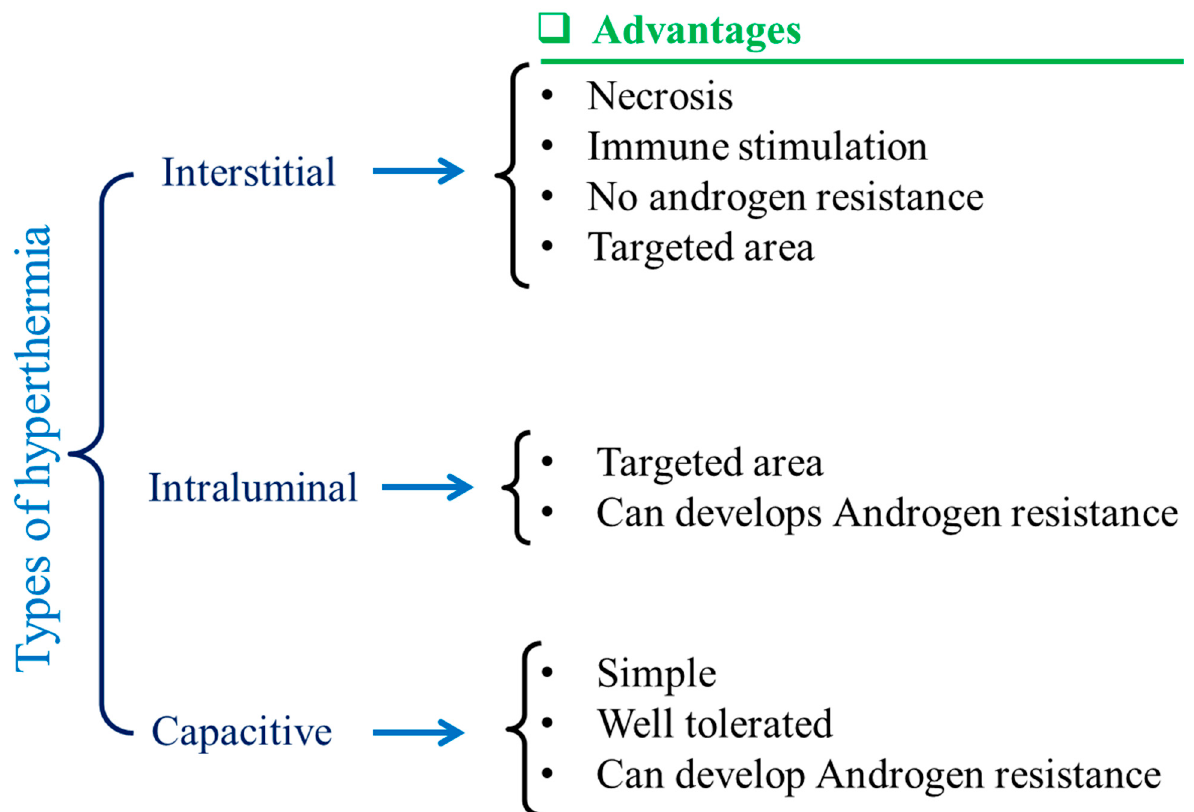
Figure 2. Schematic illustrations of different types of hyperthermia and their advantages.